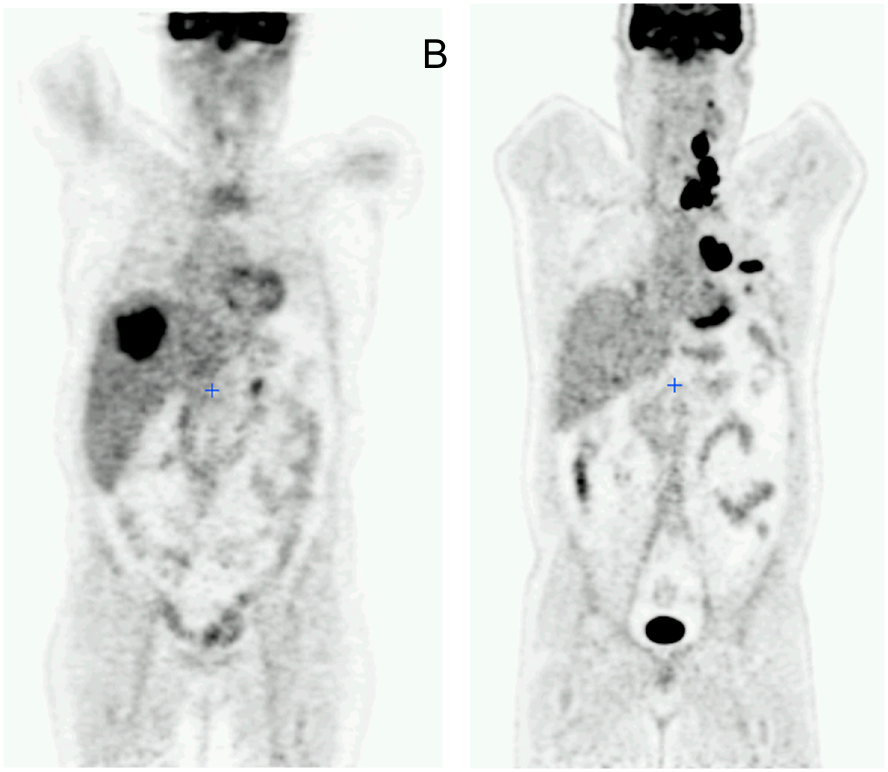
Figure 1. 18F-FDG-PET/CT acquisitions of ( A ) a 53-year-old woman, liver MTV is 181 cm 3 , and ( B ) of a 51-year-old man, mediastinum SUVmax is 42.2 g/mL. Table 2. Description of PET metrics on diagnostic 18 FDG/PET-CT.